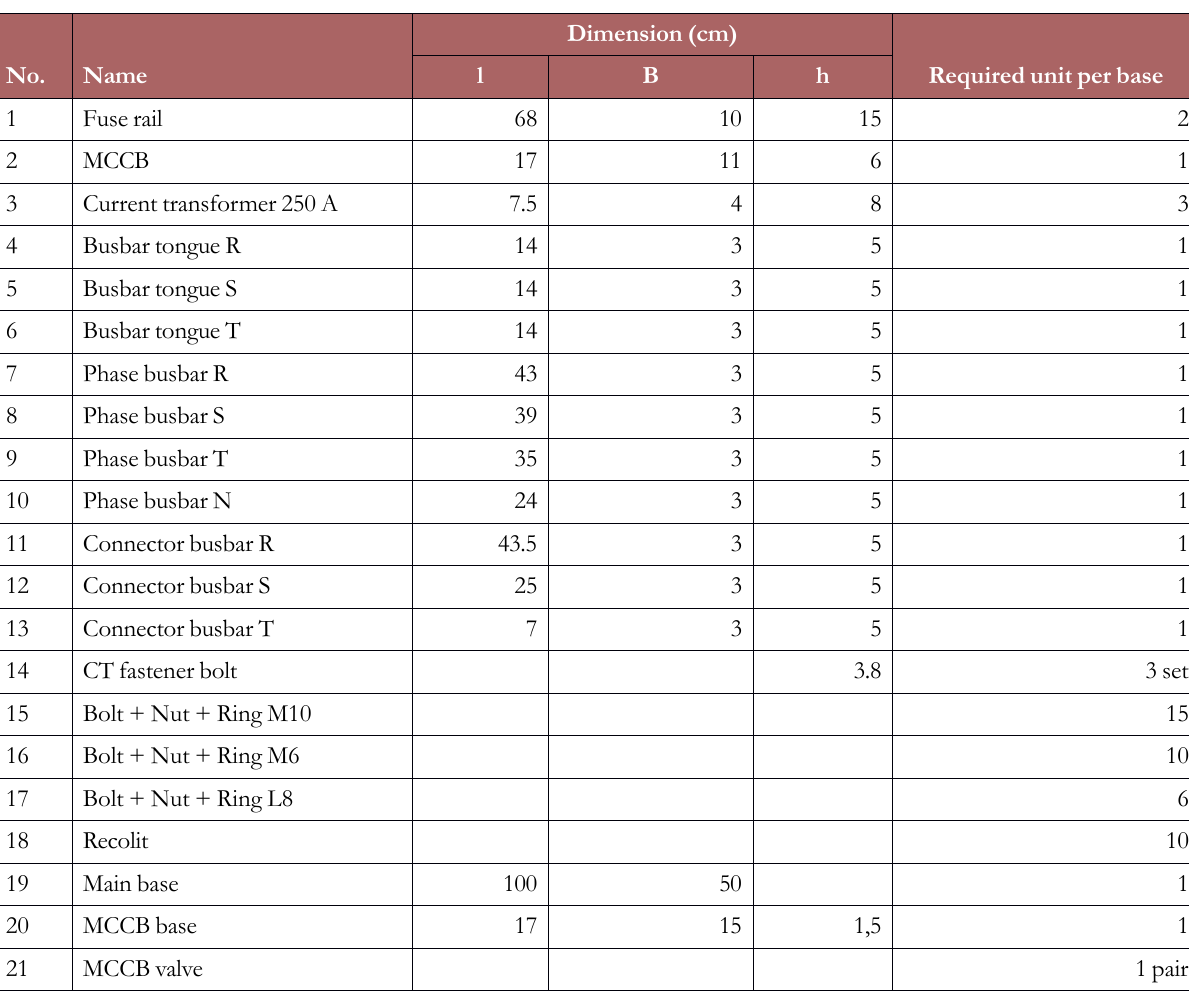
Table 3. Dimension of the PHB-TR 252 Electrical Circuit Component